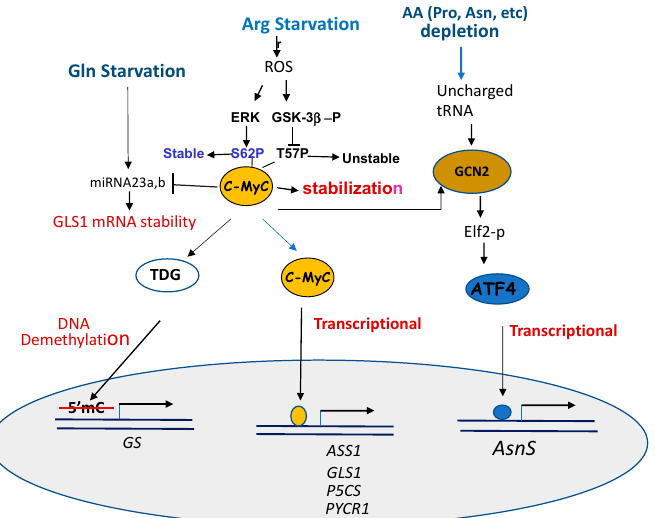
Figure 3. Multiple mechanisms of c-Myc upregulation and transcriptional induction of target genes under different amino acid-starvation conditions. Under Gln starvation, c-Myc downregulates miRNA 23a,b resulting in the stabilization of target GLS1 mRNA. Under Arg starvation, the induced ROS promotes the phosphorylation of c-Myc at S62P via an ERK intermediate and an inhibition of T57P phosphorylation, resulting in c-Myc stabilization. C-Myc also cross-talks with GCN2 in the amino acid depletion signaling, resulting in increased translation of ATF4. Both ATF4 and c-MyC can directly bind to the promoter of their targeting genes. Alternatively, c-Myc can up-regulate thymine DNA glycosylase (TDG) to induce DNA demethylation at the promoter of GS. Fifth, Gao et al. reported the link between c-Myc and Gln metabolism.